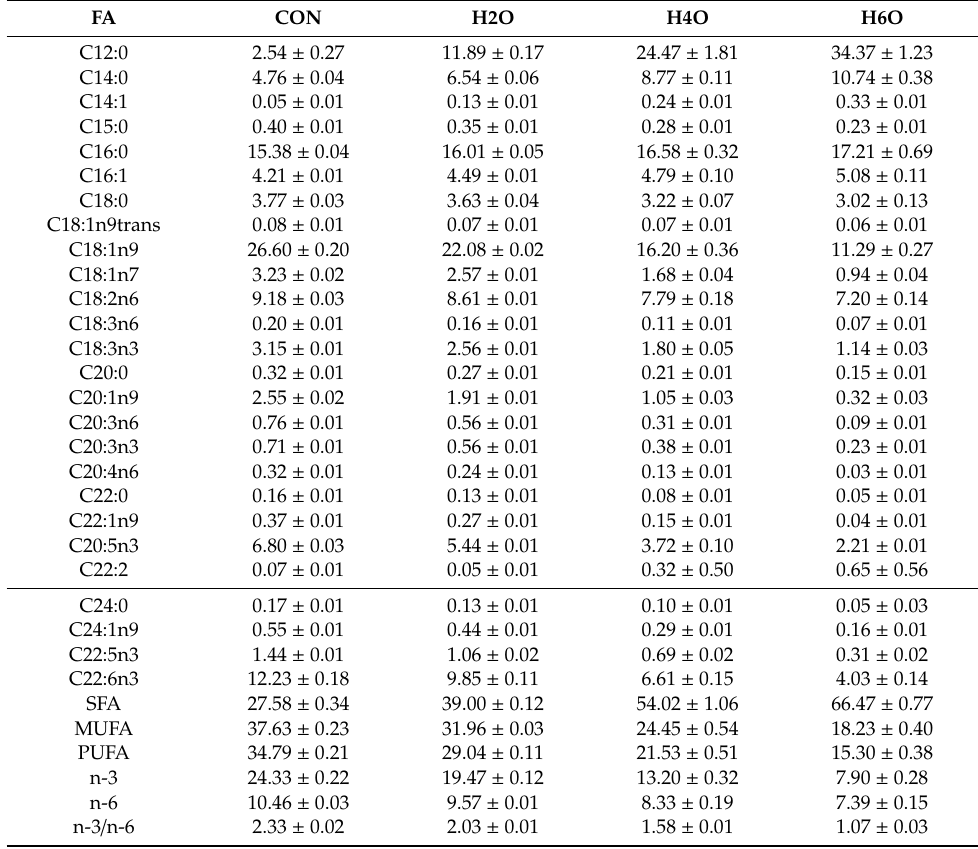
Table 3. Fatty acid profile of experimental diets for Eurasian perch. Data are expressed as percent of total FAs (mean ± SD, n =